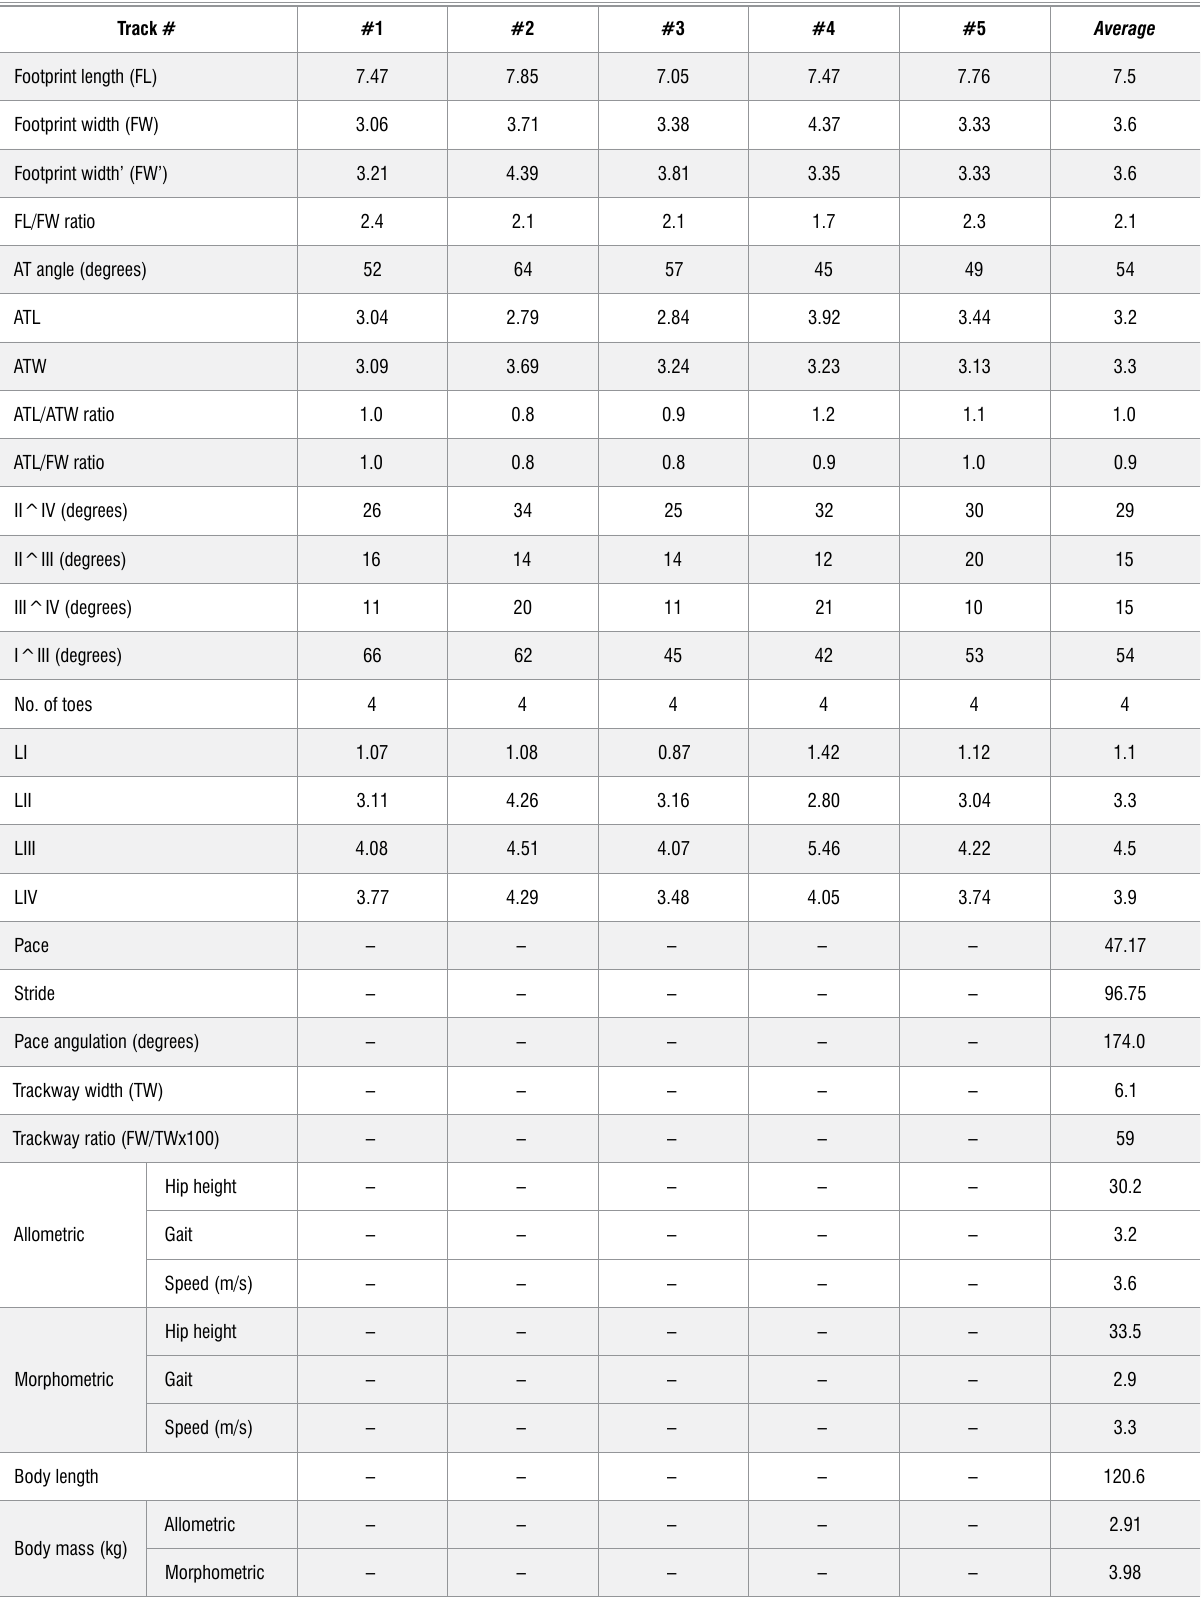
Table 1: Summary of the morphometric measurements and derived parameters of the Storm Shelter tracks. See Supplementary tables 1–4 for full morphometric measurements and calculations. Length measurements are in